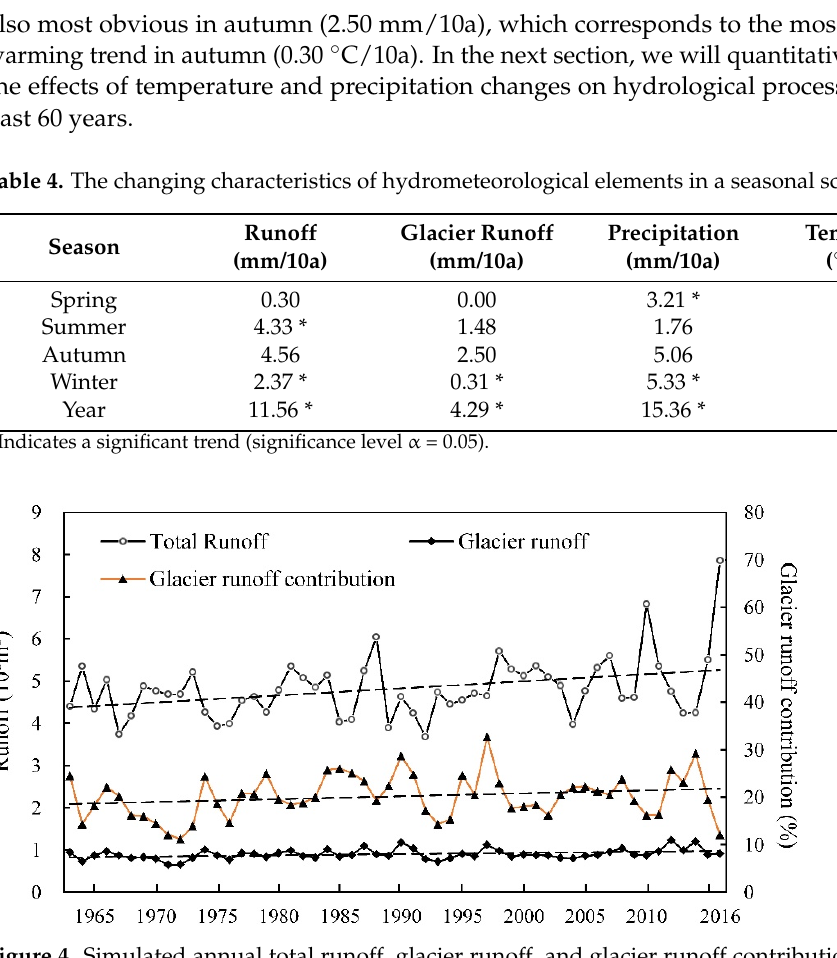
Figure 4. Simulated annual total runoff, glacier runoff, and glacier runoff contribution, as well as their variation trends.